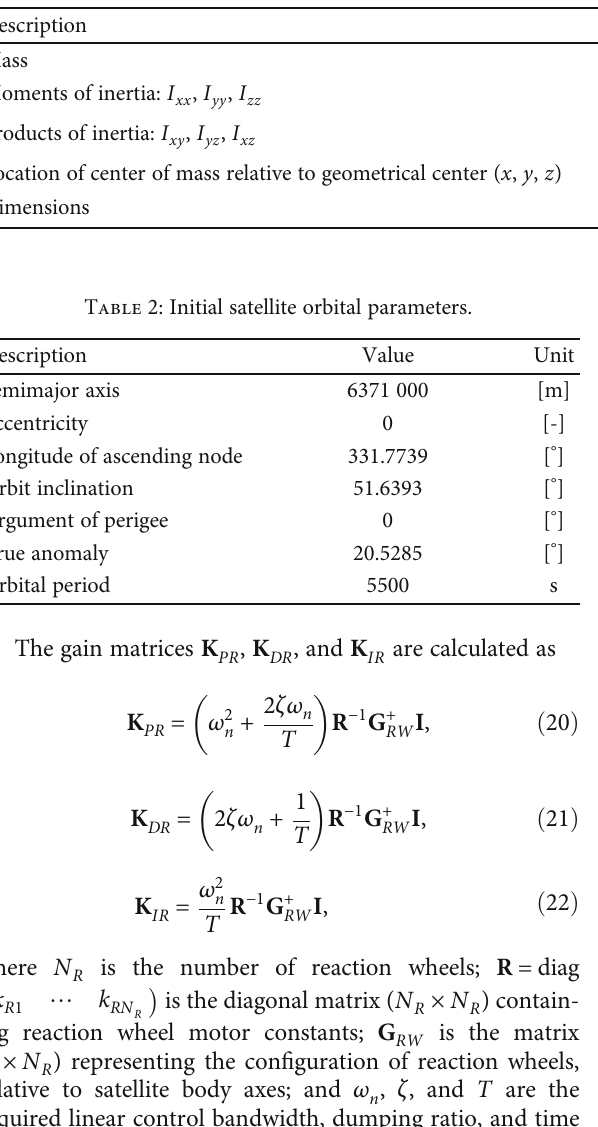
Table 1: Satellite mass properties.